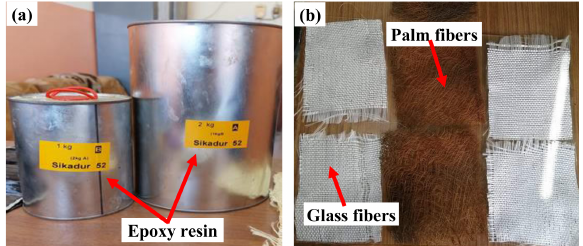
Fig. 1. The materials used in the study (a) epoxy resin branded Sikadur-52, and (b) glass fibers and natural palm